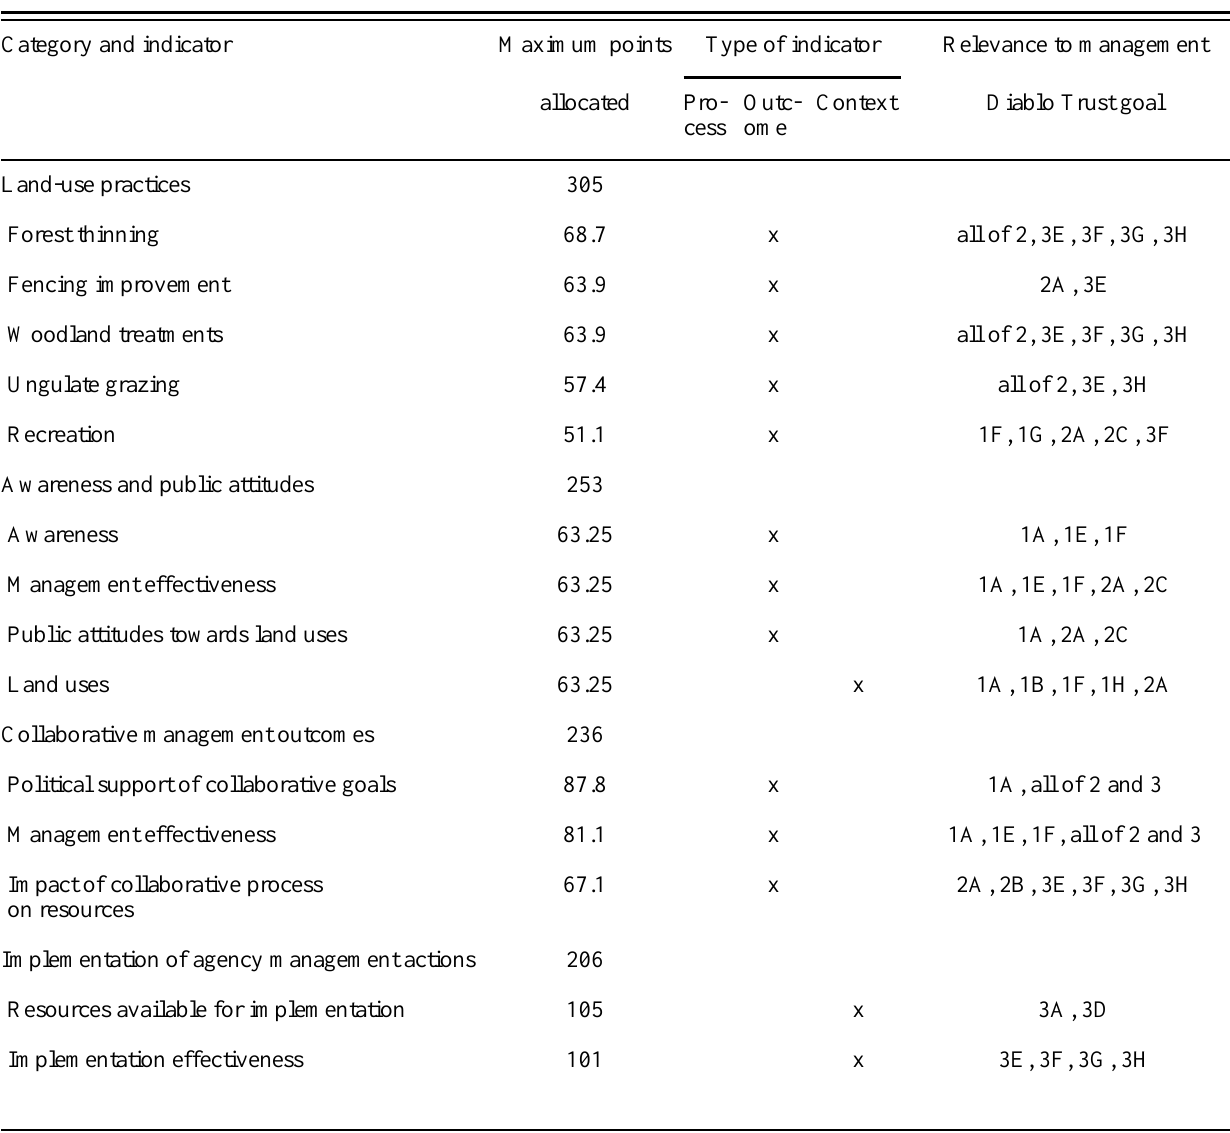
Table 6. Interactive branch indicators selected through the participatory approach to develop the holistic ecosystem health indicator for the Diablo Trust collaborative organization. The maximum points allocated are the estimated weighted points assigned to each category and fourteen indicators out of the total 1000 points. Each indicator may provide information related to the process, outcome, or context of the collaborative organization. The relevance of the indicators to the management goals was classified according to the Diablo Trust three-part holistic goal (Table